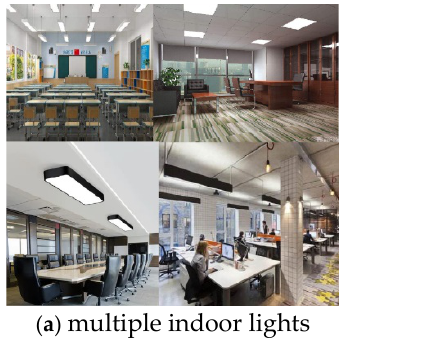
Figure 1. Interior multi-lamp, multi-core per lamp.